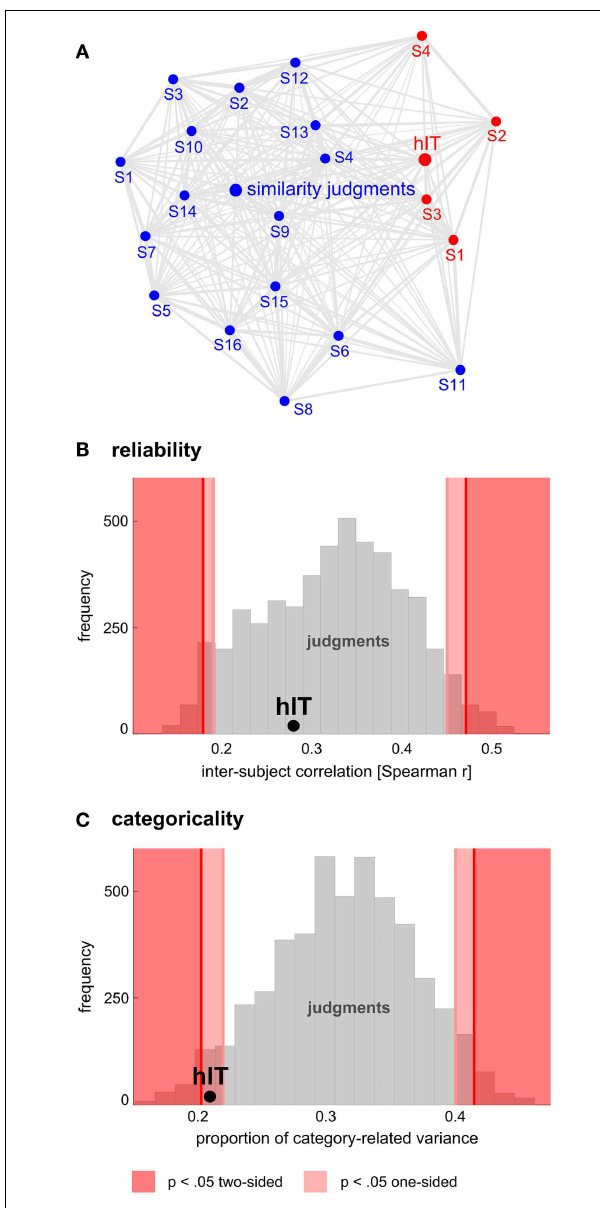
FIGURE 11 | Human judgments show similar reliability but stronger categoricality than human IT. (A) Multidimensional scaling of single-subject similarity representations (criterion: metric stress, distance measure: 1- r , where r is Spearman correlation coefficient).The MDS plot visualizes the relationships between multiple RDMs simultaneously. Text-label colors indicate the type of similarity representation: red indicates human IT, blue indicates human similarity judgments. Subject-average FIGURE 12 | Single-subject RDMs and category-model predictions for RDMs are shown in larger font.The gray connections between the RDMs human IT and human judgments. To give an impression of categoricality reflect the inevitable distortions induced by arranging the at the single-subject level, we plotted the single-subject RDMs for hIT and higher-dimensional similarity representations in a lower-dimensional space judgments (top panel), and the associated single-subject category-model (2D).Visual inspection of the MDS plot suggests that variability across predictions (bottom panel).The category-model ( Figure 5B ) was fitted to subjects is similar for judgments and hIT. (B) This panel shows inter-subject each subject’s RDM after equating inter-subject reliability between hIT and reliability for hIT and judgments.We estimated inter-subject reliability as the judgments.Visual inspection suggests stronger categoricality for the average pairwise inter-subject RDM correlation (Spearman r ), using sets of judgments than for ( Continued )